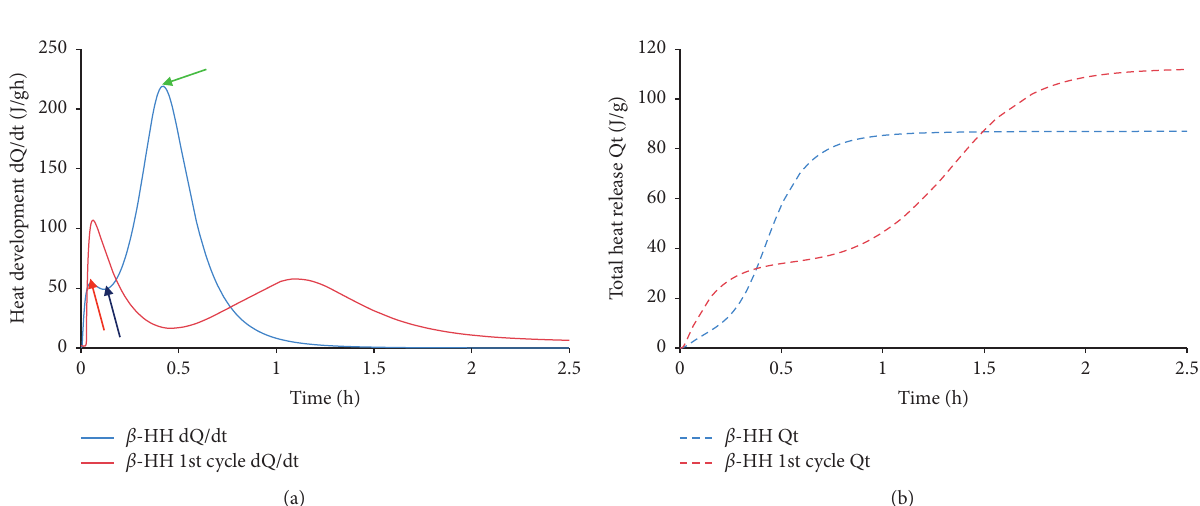
Figure 2: (a) Heat evolution curves and (b) total heat release of pure β -HH β -HH after 1st cycle.